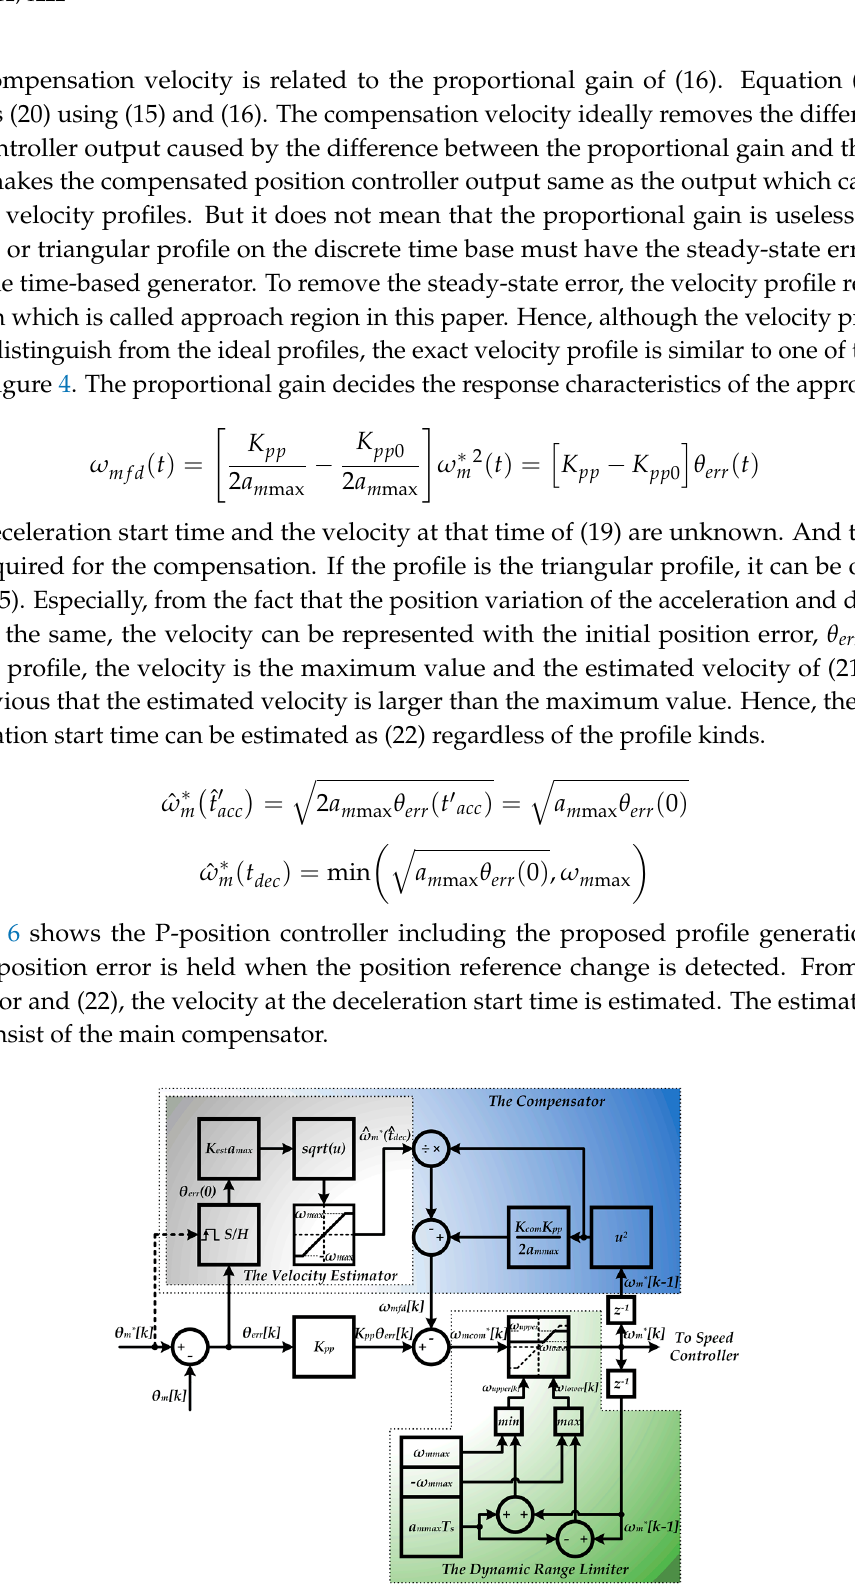
Figure 6. The position controller including the proposed profile generator. The gains of the estimator and compensator, K est and K com , are ideally 1. But the gains have to be adjusted experimentally due to some errors caused by the velocity response characteristics and the time base difference. The gains can determine the position response characteristics. Ideally, when the